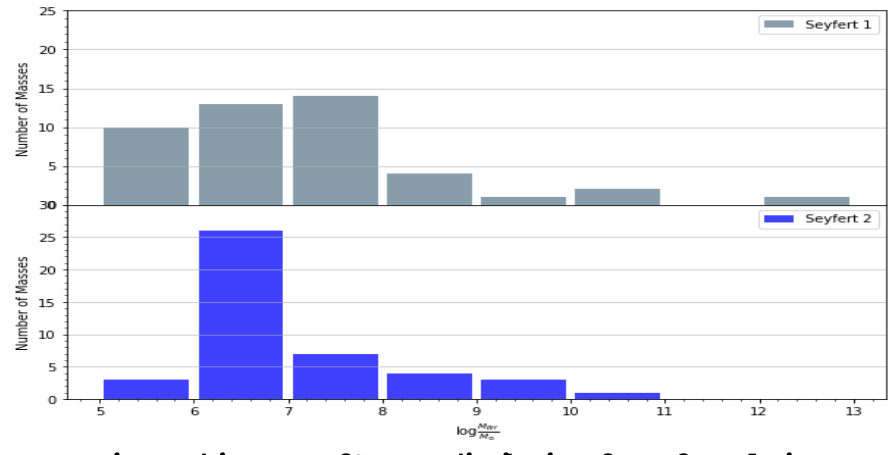
Fig.9: A histogram of SMBHs distributions for seyfert